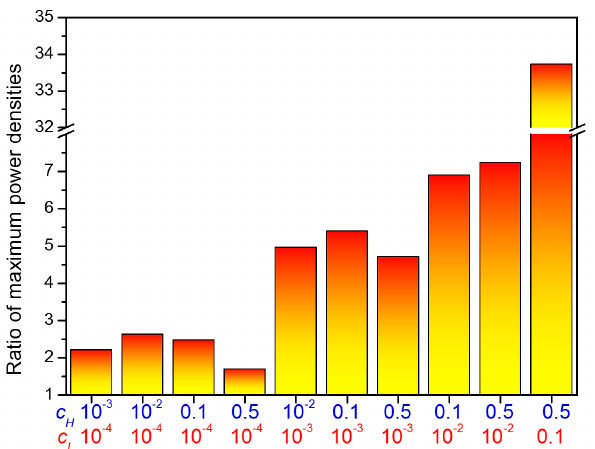
Figure 9. Ratios of the power density of the anisotropic membrane to the power density of the isotropic membrane for various combinations of concentrations.